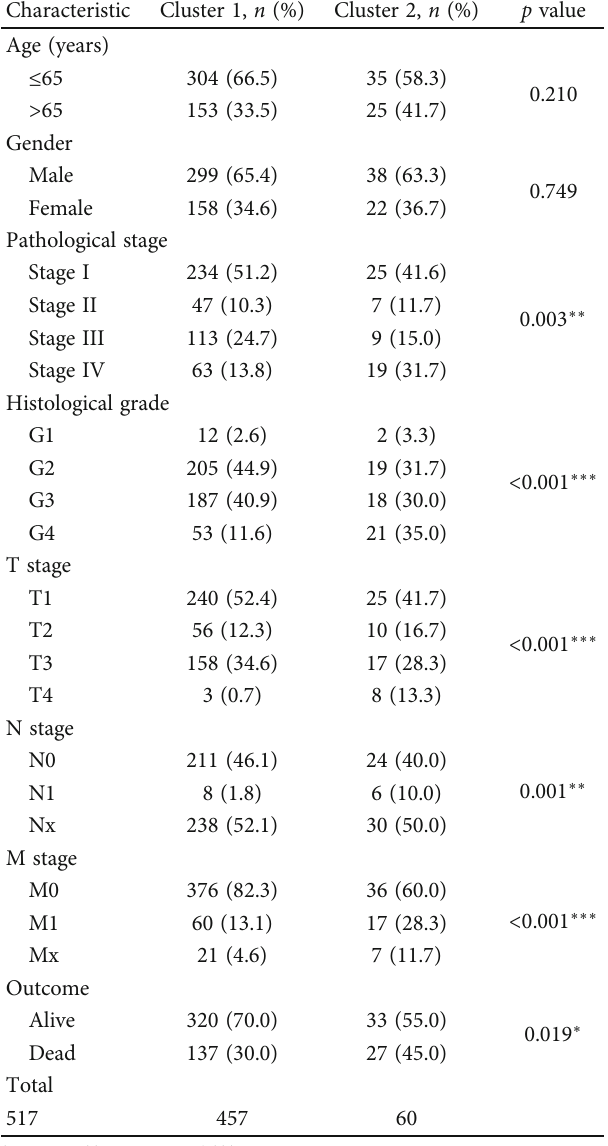
Table 2: Clinicopathological features between two clusters.